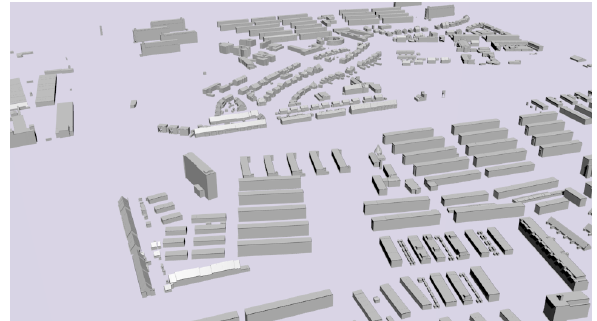
Figure 1: 3D city model of Rotterdam without semantic informa-